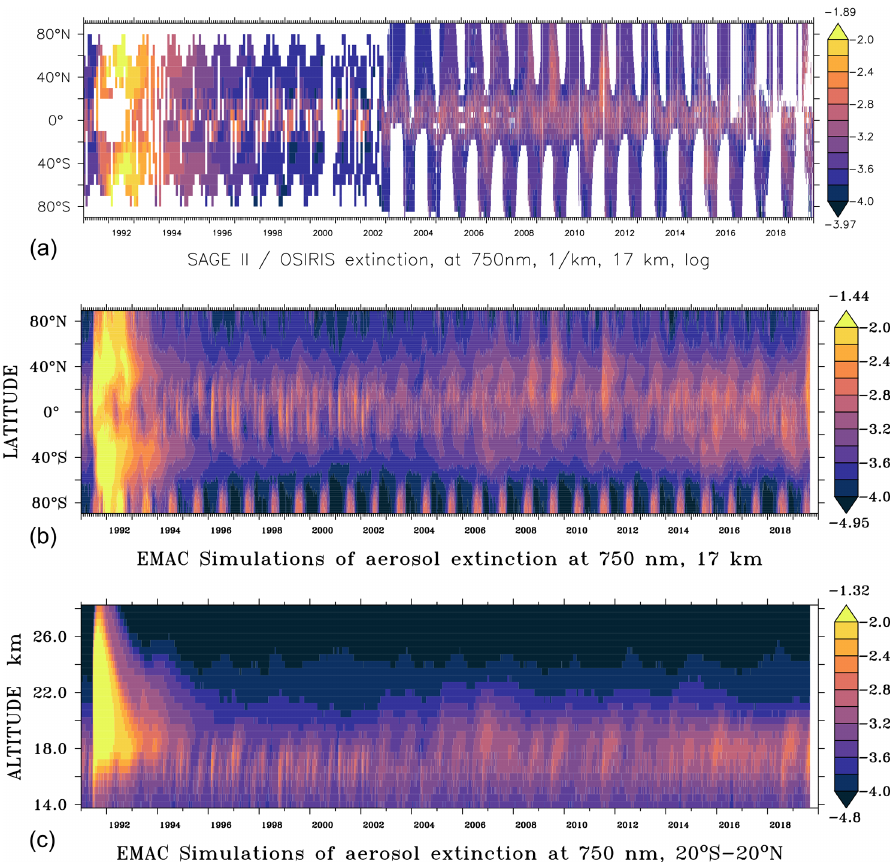
Figure 7. Comparison of stratospheric aerosol extinction for the 750nm wavelength at 17km altitude between the model simulations (b) and SAGE II and OSIRIS satellite data (a) ; all values on a logarithmic scale log(km − 1 ). Vertical distribution of EMAC results for tropical regions 20 ◦ S–20 ◦ N in panel (c) . Maximum and minimum values appear above (yellow) and below (dark blue) the colour keys, respectively. Five-day averages, except for monthly SAGE